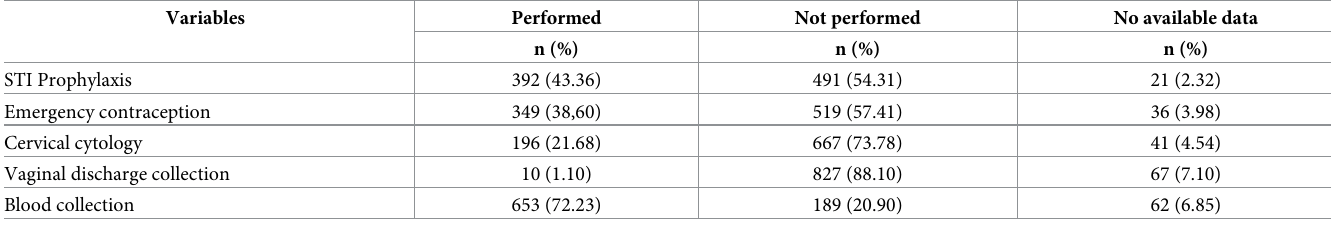
Table 2. Procedures performed in women in situations of sexual violence assisted by PAVI´VIS between 2010 and 2019 (N = 904 � ).